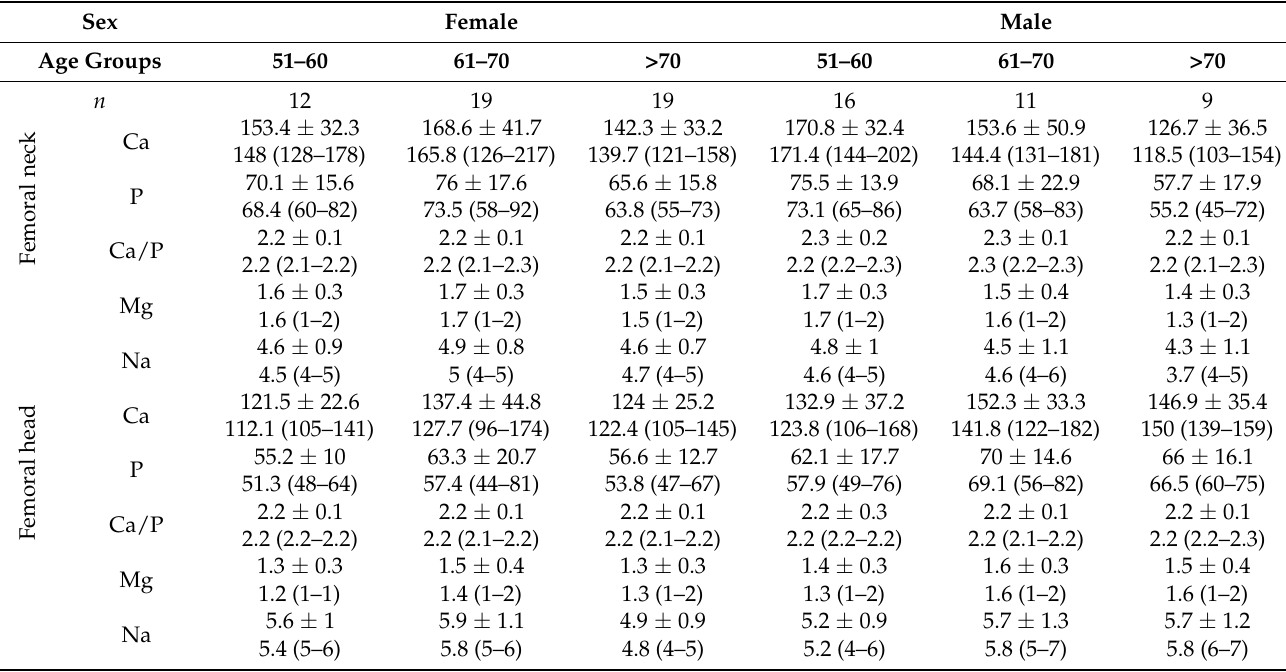
Table 1. Concentrations of elements (in g/kg on the dry mass basis) (mean ± SD and median (Q1–Q3)) in the femoral head and neck in the sex and age groups ( N = 86).